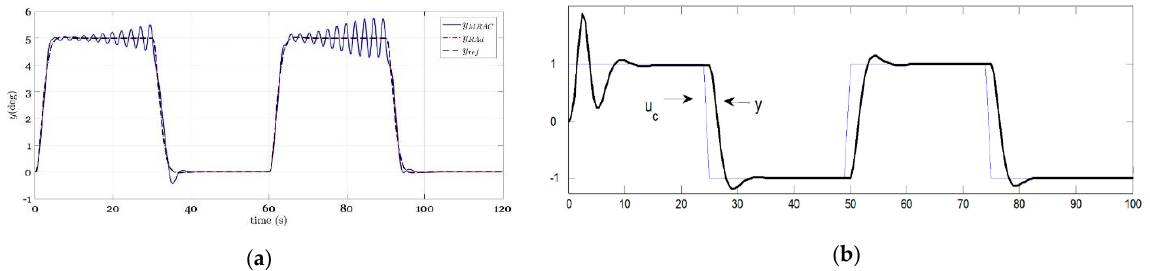
Figure 1. Contextual preface: model-reference and self-tuning regulator adaptive controllers following square waves. ( a ) Context: model-reference adaptive control in [31] following a (sloped) square wave. ( b ) Context: indirect self-tuning regulator in [11] following a (sloped) square wave.